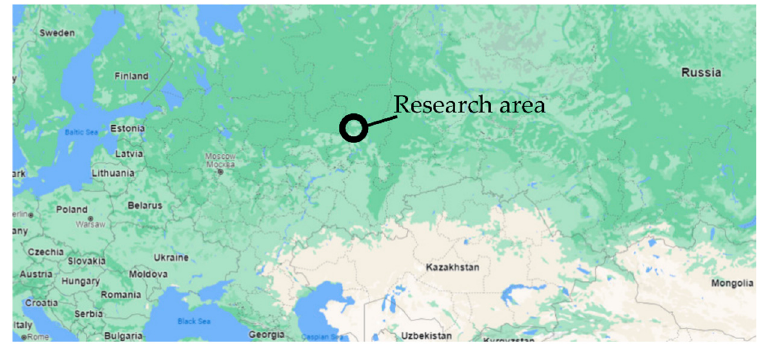
Figure 5. Research area (using Google Maps). Table 5. Geological parameters of the Tournaisian carbonate reservoirs (Nozhovskaya group of fields).